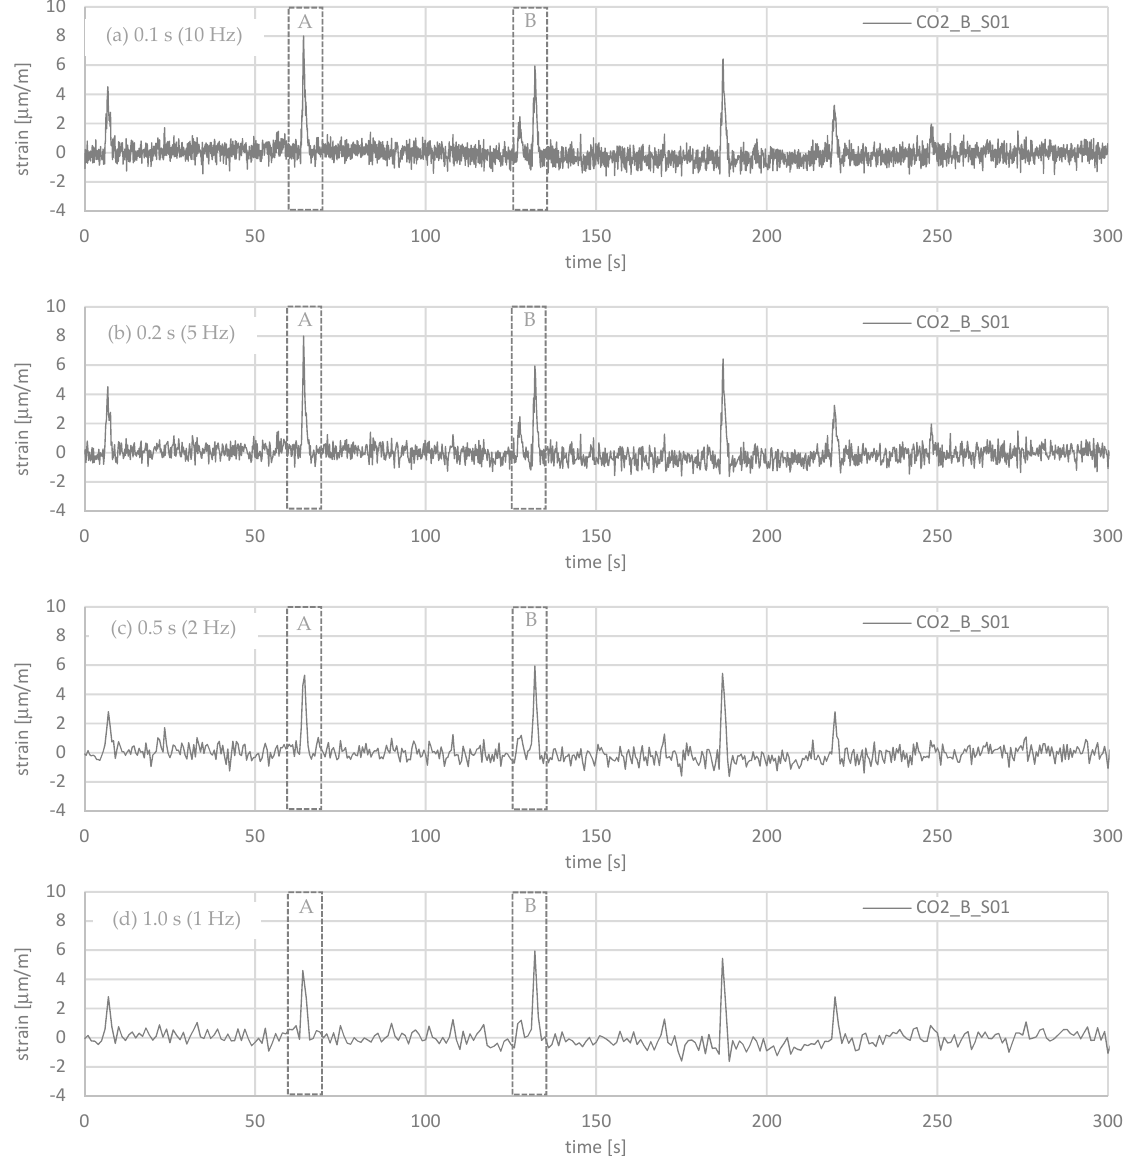
Figure 6. Influence of the sampling rate to the strain measurement over a period of 5 min at Gerber hinge C: ( a ) 0.1 s (10 Hz); ( b ) 0.2 s (5 Hz); ( c ) 0.5 s (2 Hz); ( d ) 1.0 s (1 Hz).